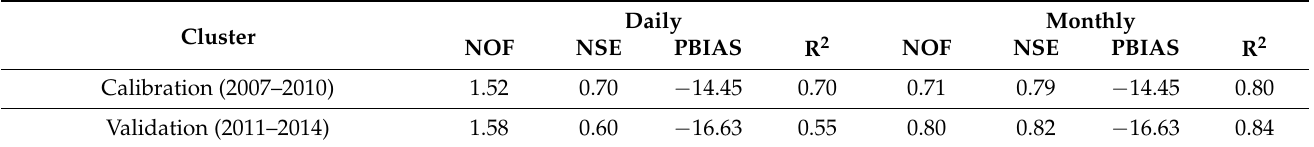
Table 2. Statistical performance criterions during calibration and validation for the HEC-HMS model.